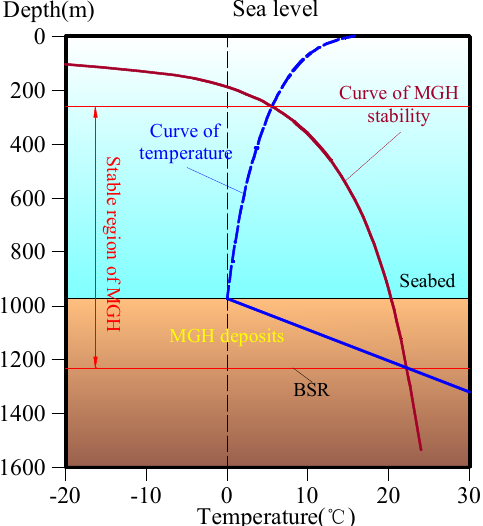
Figure 2. Pressure-temperature equilibrium curves for MGHs [2].